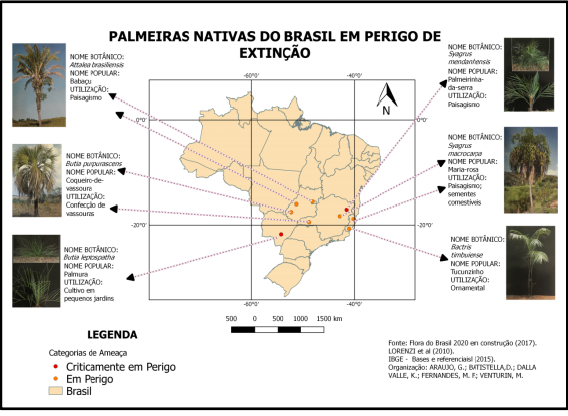
Figure 3. Palm trees in extinction risk in